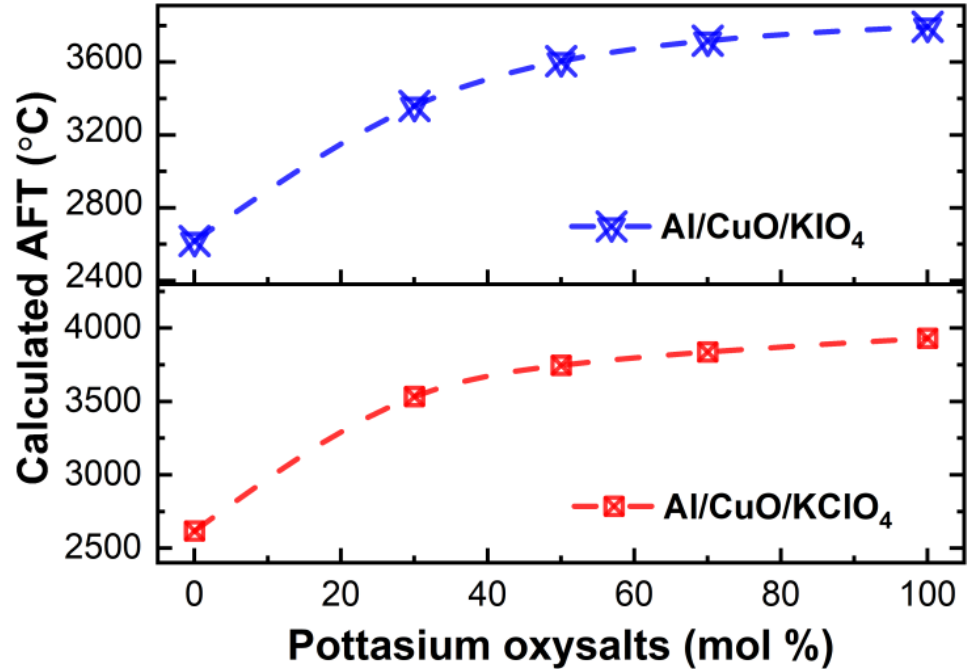
Figure 1. The calculated AFT of Al/CuO/potassium oxysalts systems by REAL.